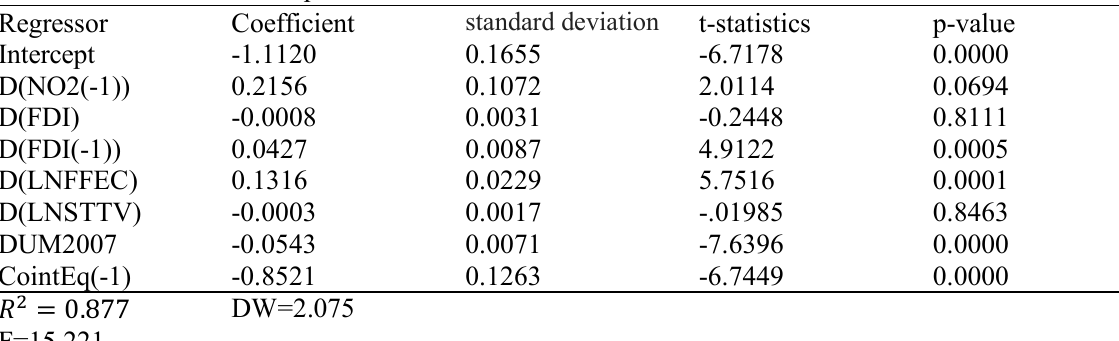
Table 7. Error correction representation for the selected ARDL selected based on